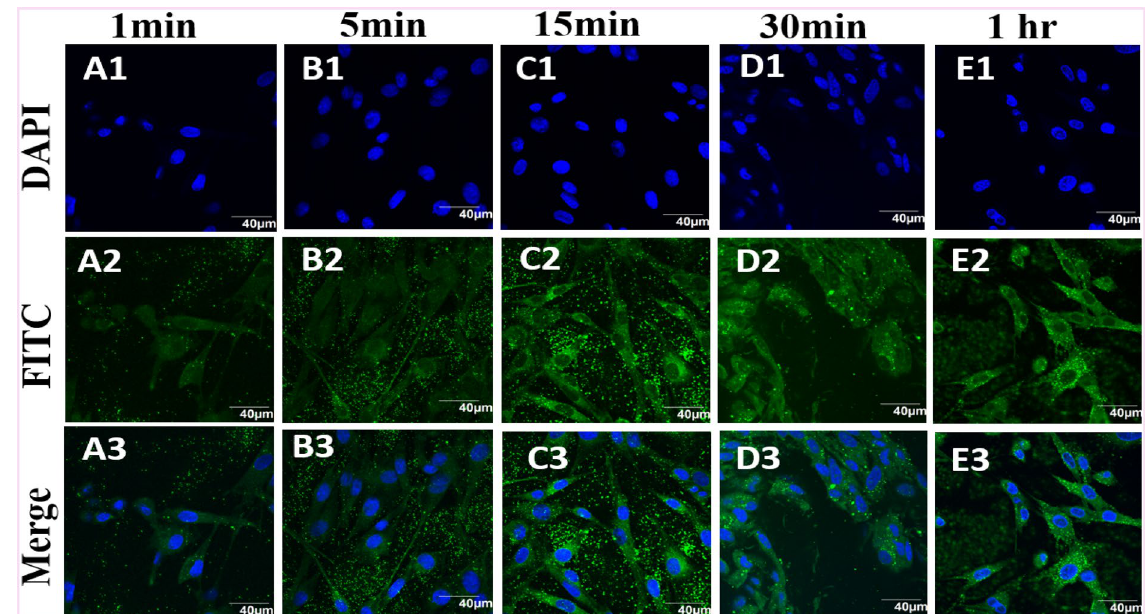
Figure 3. Time based tracking of PVC NPs (200 µg/mL) exposed to BHK-21 cells. Top to bottom rows: Hoechst stain in DAPI channel, NPs appear as green in FITC channel, overlay of blue and green channels. Images observed at ( A1 – A3 ) 1 min, ( B1 – B3 ) 5 min, ( C1 – C3 ) 10 min, ( D1 – D3 ) 30 min, and ( E1 – E3 ) 1 h are given to compare the time dependance internalization of PVC particles. All images were recorded using an Olympus FV1000 confocal microscope. The control experiment for all the time points are given in the supporting information, Figure